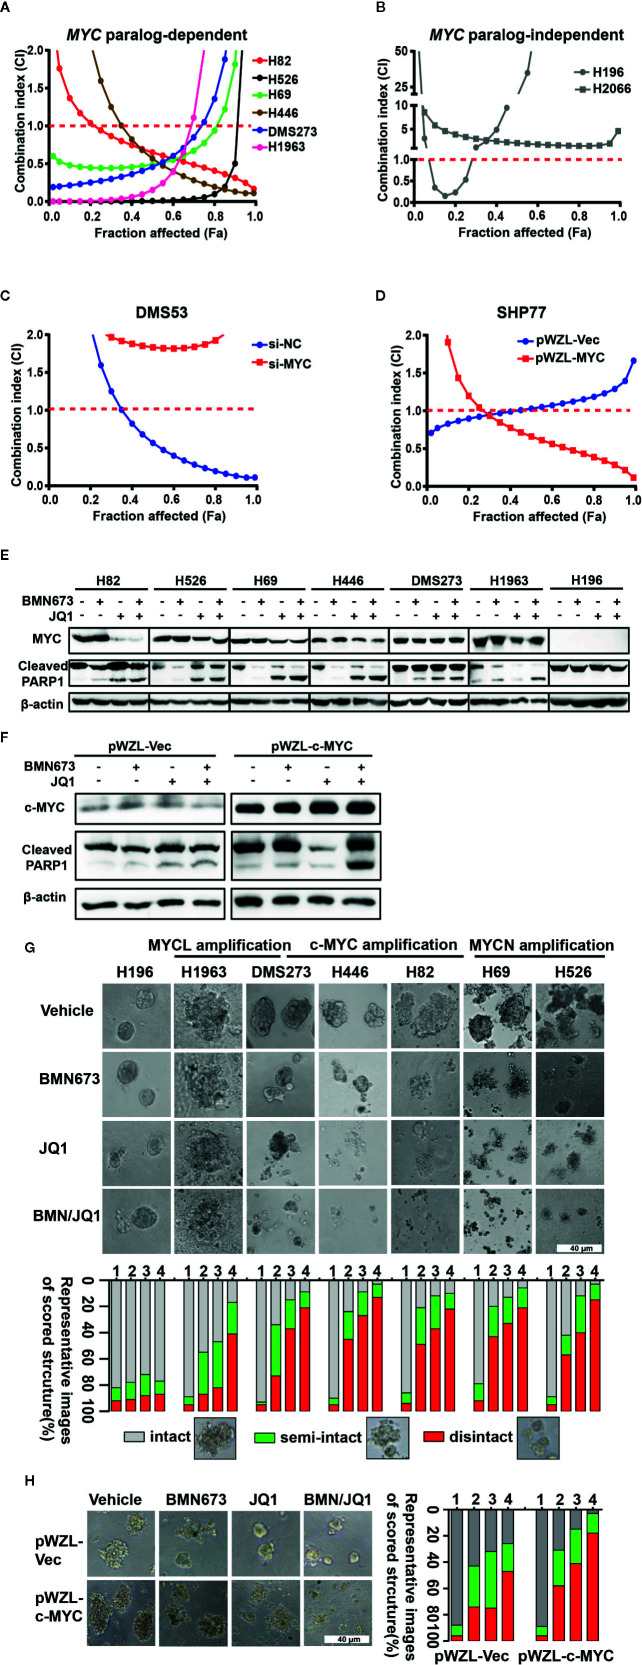
The combination effects of JQ1 and BMN673 in SCLC cells. (A–D) CellTiter-Glo Luminescent assays demonstrating the effects of JQ1 and BMN673 as single agents or in combination in MYC paralog-dependent (A), independent (B) SCLC cells, DMS53 cells with c-MYC knockdown (C), and SHP77 cells with c-MYC overexpression (D). A mathematical model was applied to calculate the combination index using the CalcuSyn software program. (E) Western blot analysis of cleaved PARP and MYC paralogs in SCLC cells treated with BMN673 or JQ1 alone or in combination for 24 h. c-MYC for H82, H446 and DMS273, MYCN for H526 and H69, MYCL for H1963. (F), Western blot analysis of cleaved PARP and c-MYC in SHP77 cells with c-MYC overexpression followed by BMN673 and JQ1 treatment alone or in combination for 24 h. GAPDH was used as a loading control. (G) Tumor sphere structures in 3D matrigel were captured under a phase-contrast microscope upon treatment of JQ1 and BMN673 as single agents or in combination for 10 to 15 days. Representative images of tumor spheres were shown in the top panel. Quantification of scored tumor sphere structures (disintegrated, semi-disintegrated, and intact) was shown in the bottom panel. Scale bar, 40 μm. (H) 3D matrigel assays showing the effect of JQ1 and BMN673 in SHP77 cells with or without c-MYC overexpression. 1, Vehicle; 2, BMN673; 3, JQ1; 4, JQ1+BMN673.